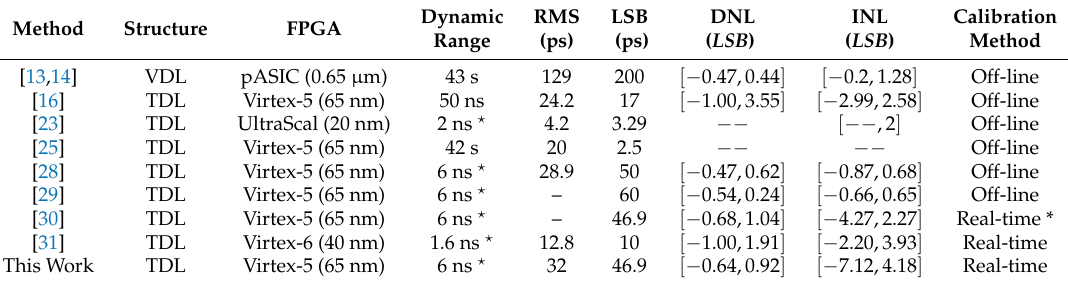
Table 1. Comparison with FPGA-based TDCs. LSB, least significant